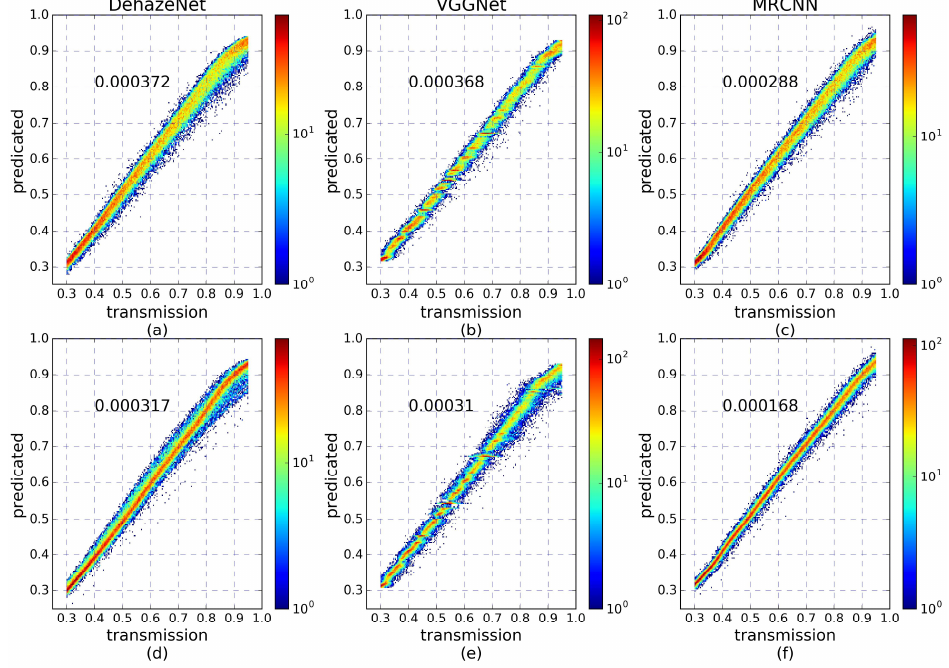
Figure 15. The density plots between the predicted and truth transmission for DehazeNet, VGGNet, and the proposed MRCNN. ( a – c ) the results using the testing set of D1 during the original training process; ( d – f ) the results using the testing set of D2 during transferring